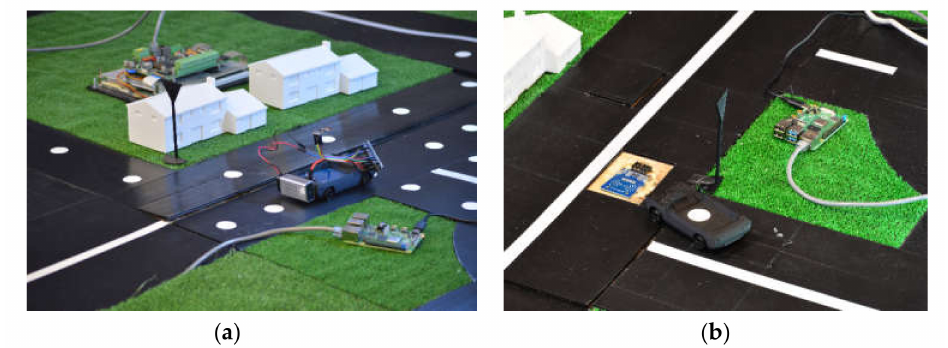
Figure 20. Lab tra ffi c model with RFID infrastructure: ( a ) a vehicle equipped with RWD crossing an intersection and turning right; ( b ) a vehicle with RFID transponder passing over